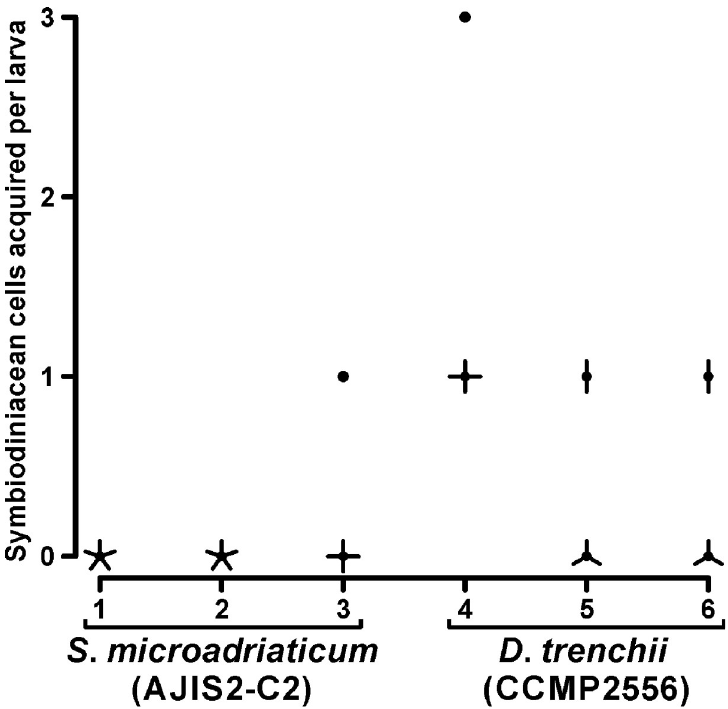
Fig 7. The symbiodiniacean cell numbers within larvae under red LED light source. Acquired cell numbers are shown in a sunflower plot for each experimental cup separately. Number of leaves (petals) indicating that individual larvae harbored the same numbers of symbiodiniacean cells. Five individual six-day-old larvae were observed in each experimental cup.